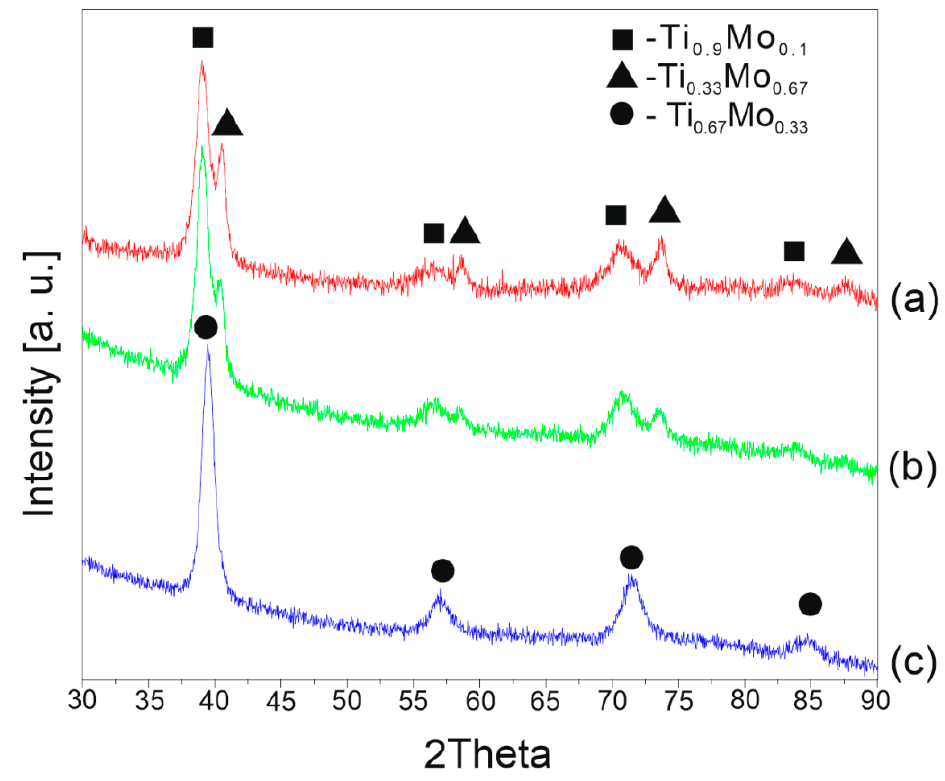
Figure 1. X-ray diffraction (XRD) patterns of Ti23Mo ( a ), Ti27Mo ( b ), Ti35Mo ( c ) after 48 h of mechanical alloying (MA).